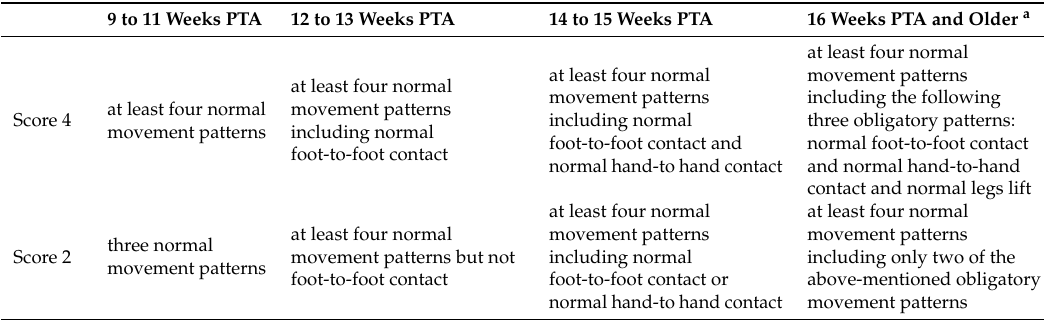
Figure 3. Illustration of the postural item “Body Symmetry. ” Score normal if an imaginary line through the shoulder joints and an imaginary line through the hip joints run parallel (left; green lines). Score atypical if this is not the case (right, red lines). Table 2. How to score the age-adequate movement repertoire, i.e., subcategory (iii) of the Motor Optimality Score, in three- to five-month-old